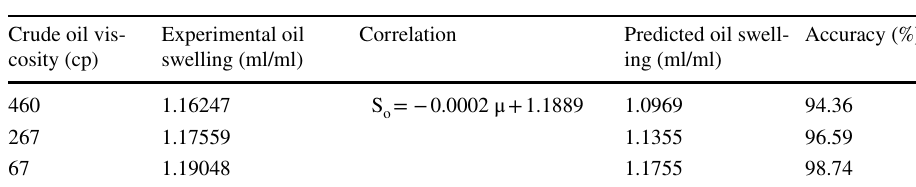
Table 4 Accuracy of oil viscosity